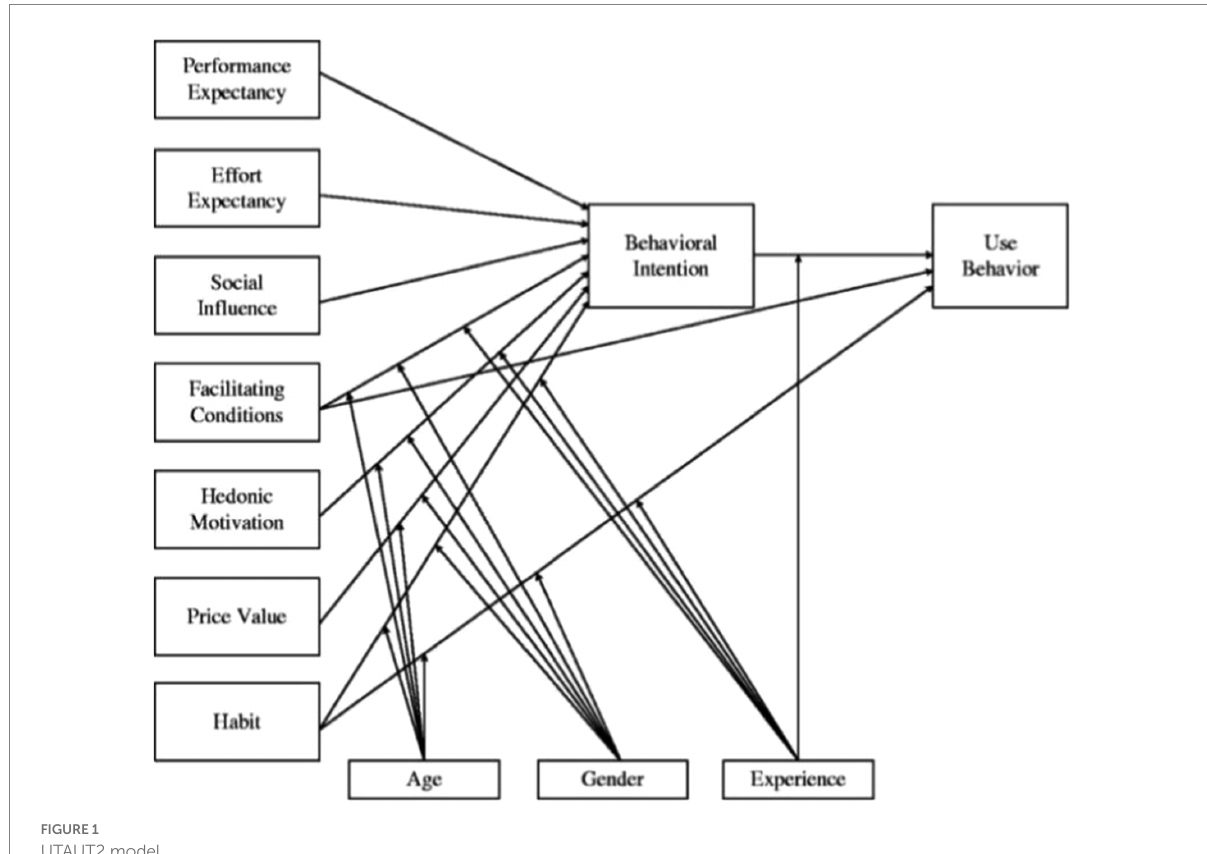
FIGURE 1 UTAUT2